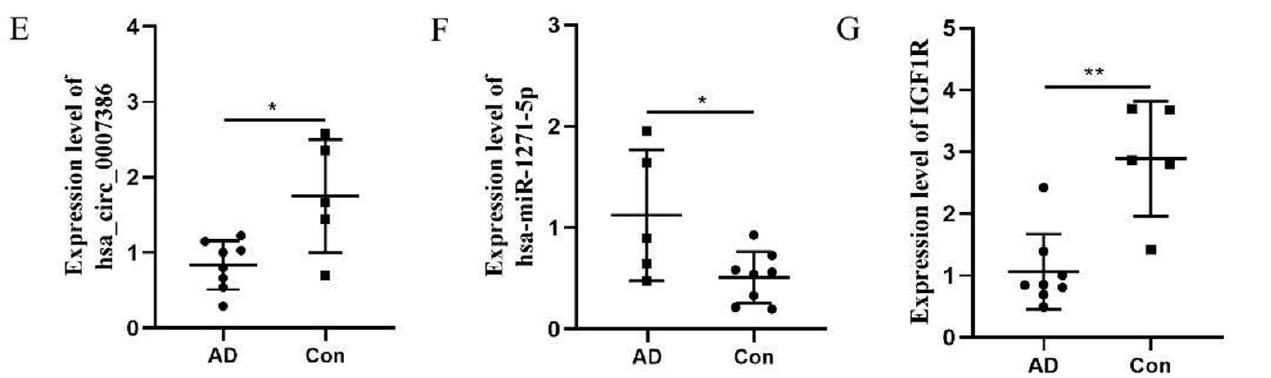
Figure 6. Signal axis screening and specimen verification. ( A ) Sankey diagram for the circRNA-microRNA-mRNA-pathways axis screened out in this study. Each rectangle represents a gene or pathway, and the connection degree of each gene is visualized based on the size of the rectangle. ( B – D ) The expression levels of the hsa-cic-0007386/miR-1271-5P/IGF1R between the TAD and CON group in the GSE97745, GSE98770, and GSE52093 datasets, respectively. * p < 0.05, ** p < 0.01. ( E – G ) The expression levels of the hsa-cic-0007386/miR-1271-5P/IGF1R between the TAD and CON group in our aortic dissection specimen. * p < 0.05, ** p < 0.01.